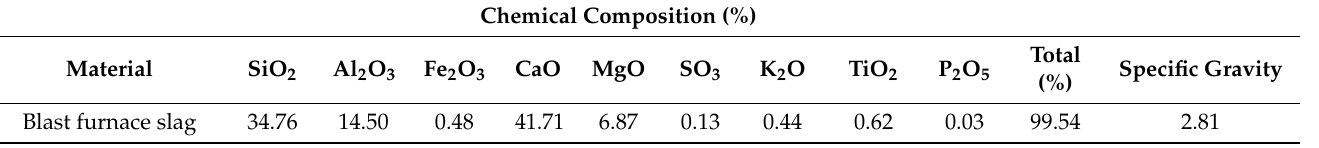
Table 1. Chemical composition of